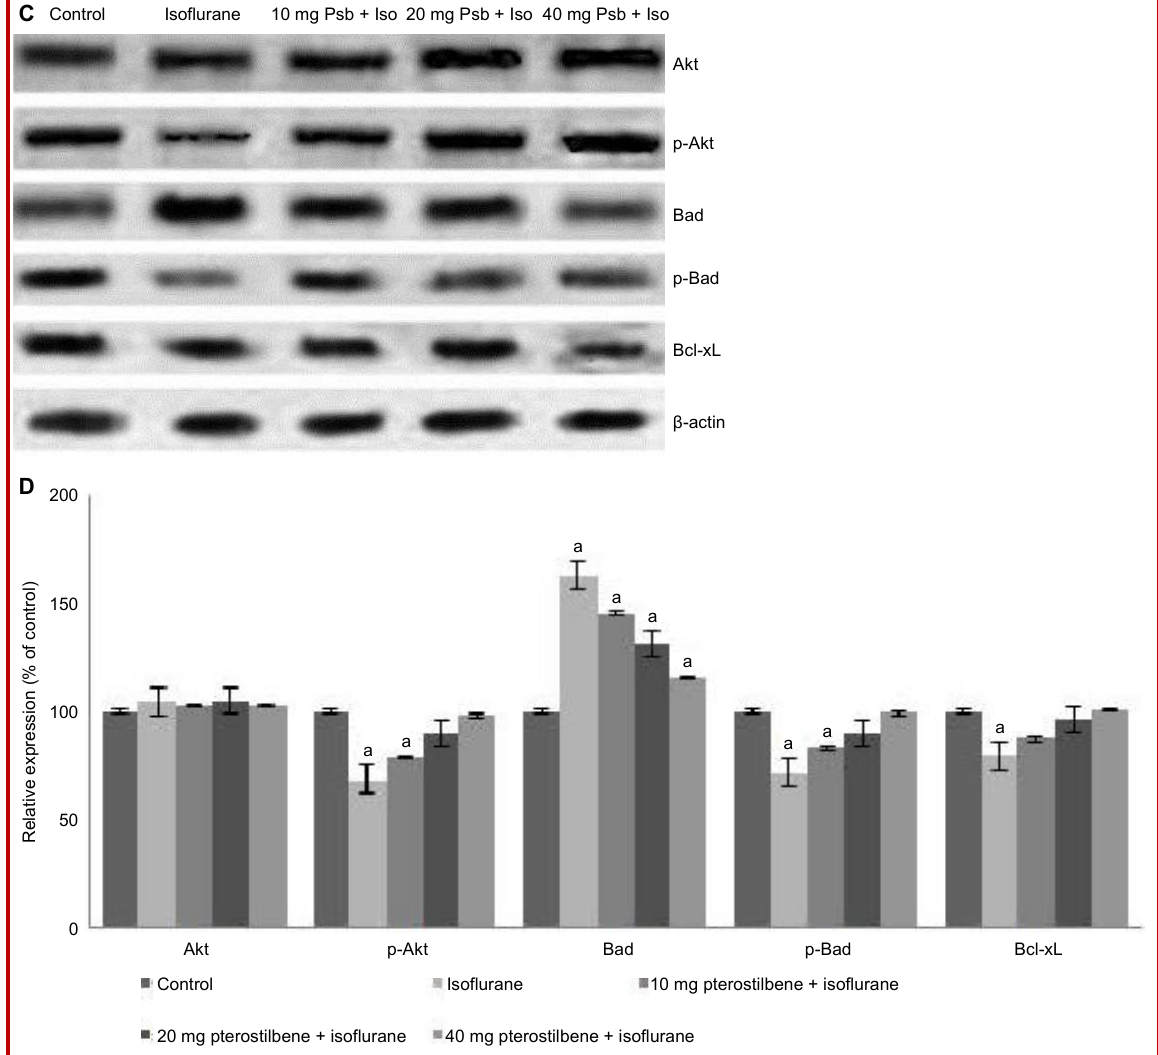
Figure 2 (A-D): Influence of pterostilbene on the expression of caspase -3, JNK and PI3/Akt pathway proteins (Cont.) C- Control; Iso-Isoflurane; Psb- Pterostilbene; Relative expression of caspase -3 and signalling pathway proteins (A and C). Values are represented as mean ± SD; n=6 (B and D); a represents statistical significance at p<0.05 compared against control as determined by one -way